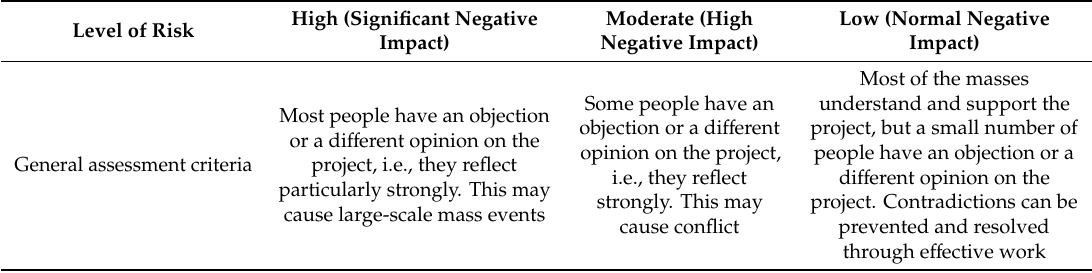
Table 4. Social stability risk rating criteria for